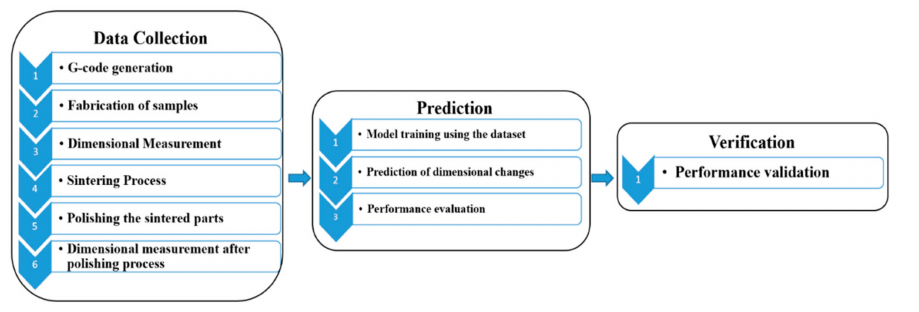
Figure 3. Process workflow of the research